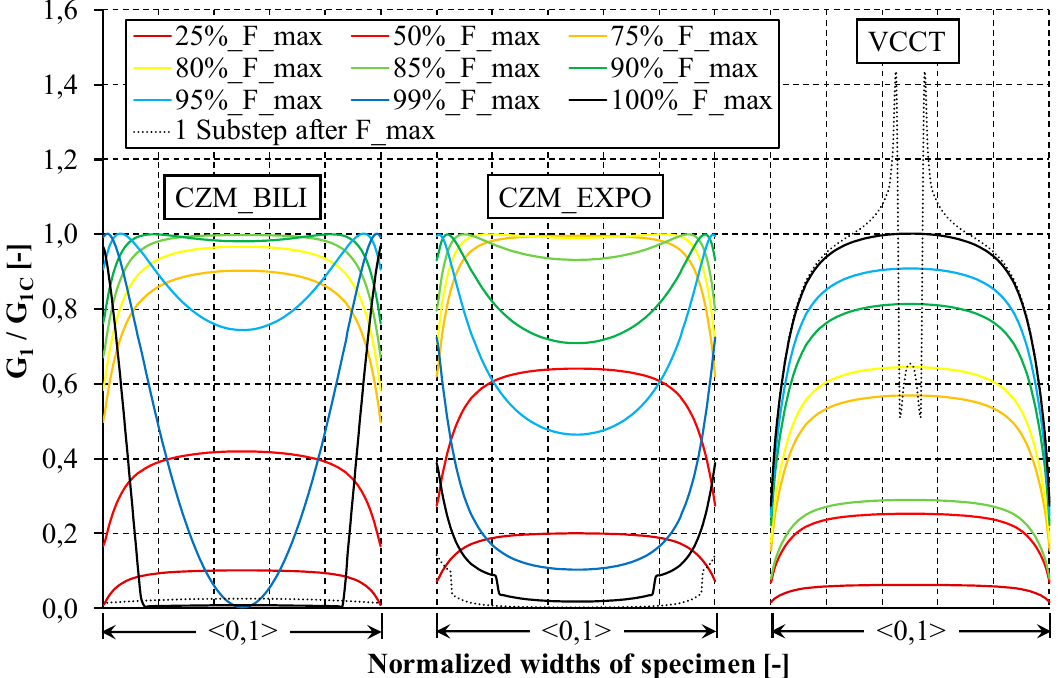
Figure 10. Dimensionless distribution of the SERR along the initial delamination front.